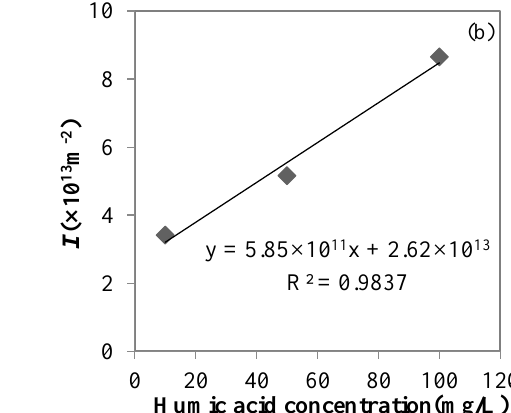
Figure 5. Cake layer model fitting for the NF process of a 10 mg/L humic acid solution ( a ) and the correlation between I and the influent humic acid concentration ( b ).